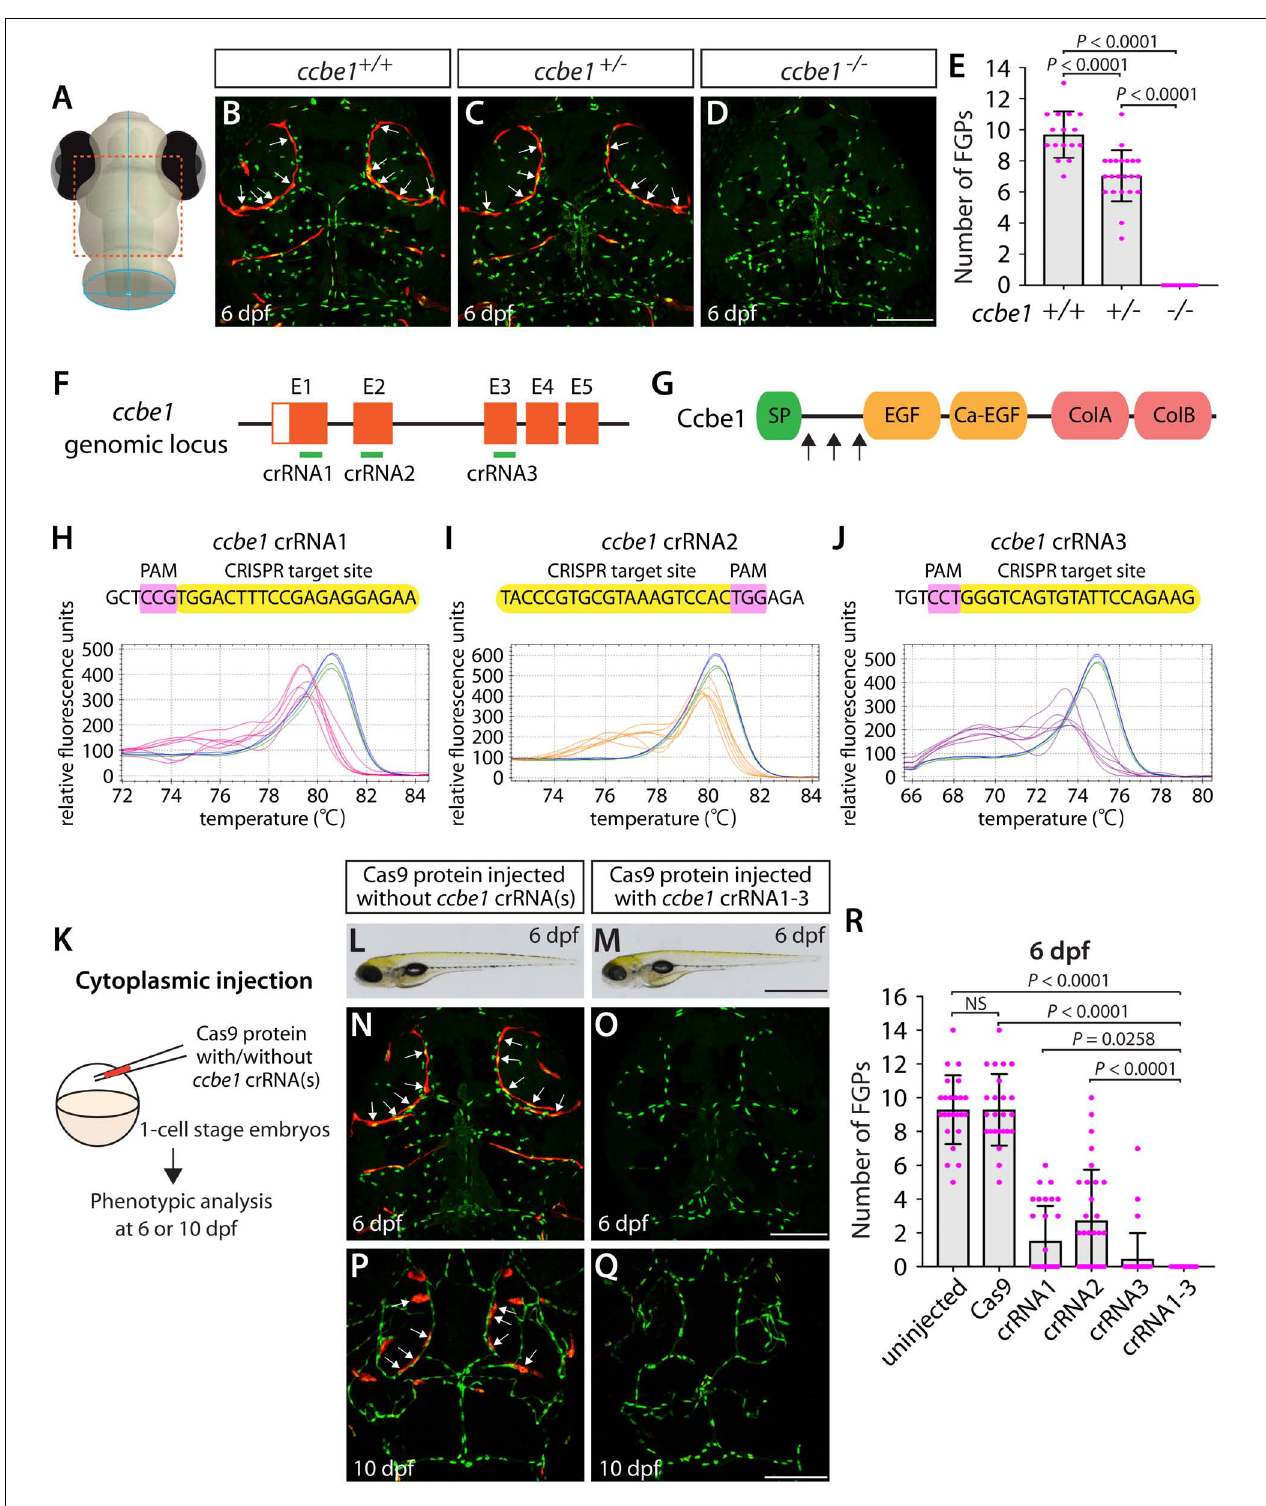
FIGURE 3 | Larvae injected with three unique ccbe1 dgRNPs phenocopied the complete loss of brain meningeal perivascular FGPs observed in ccbe1 − / − fish. (A) Schematic representation of the dorsal view of the zebrafish larval head. The boxed area indicates the approximate region where the confocal images of panels (B–D) were captured. (B–D) Dorsal head views of 6 dpf ccbe1 + / + , ccbe1 + / − , and ccbe1 − / − larvae carrying Tg(fli1:nEGFP) and Tg(lyve1:DsRed) transgenes. While ccbe1 + / + and ccbe1 + / − larvae formed Tg(fli1: nEGFP );Tg(lyve1: DsRed ) -double positive FGPs in the dorsal meningeal surfaces over the optic tectum (arrows, B,C ), ccbe1 − / − larvae completely lacked FGPs (D) . (E) Quantification of FGPs over the optic tectum for each genotype at 6 dpf ( n = 16 for ccbe1 + / + , n = 22